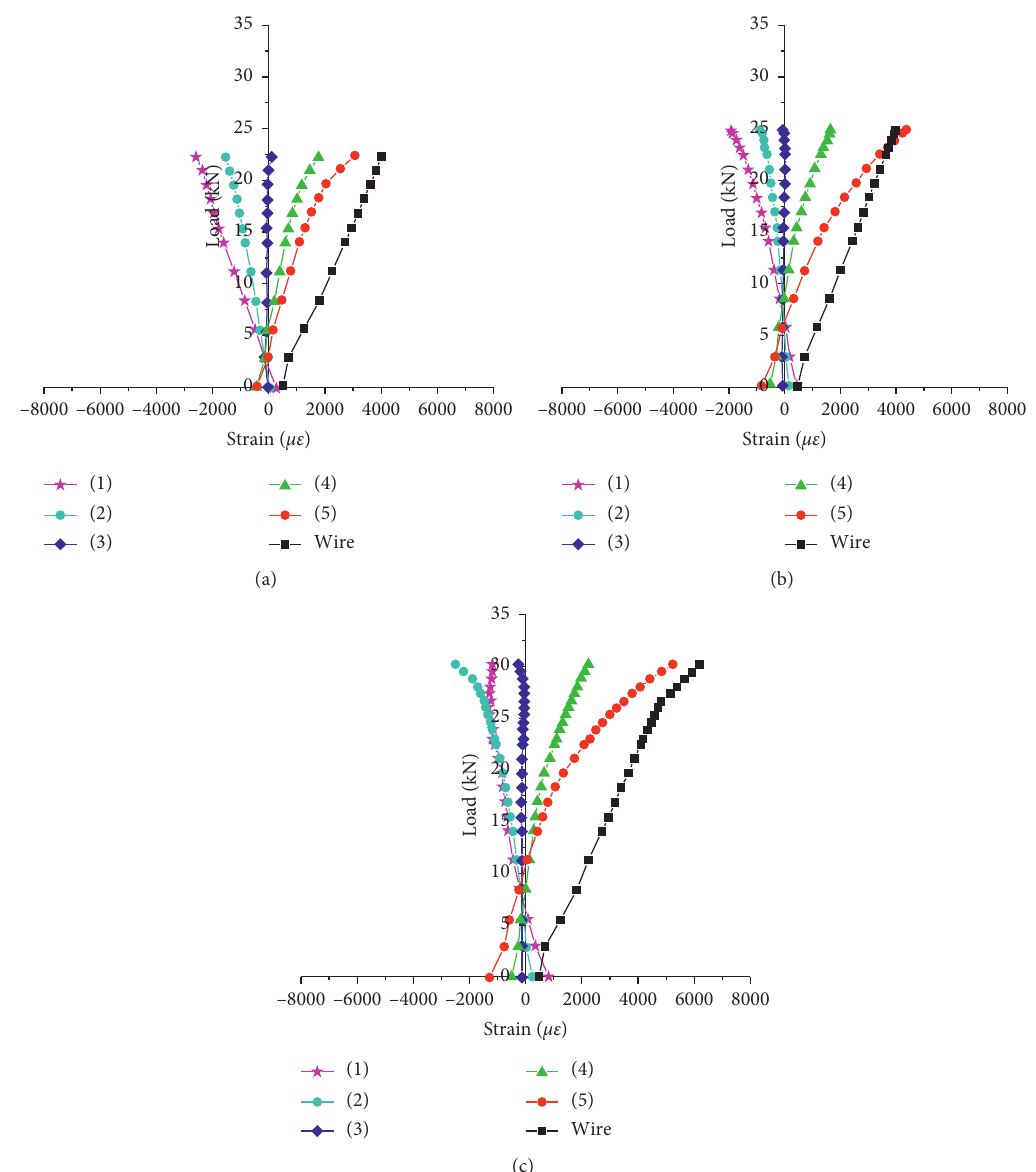
Figure 8: Load-strain relationship curve in group A. (a) SPF-1.1. (b) SPF-1.2. (c)